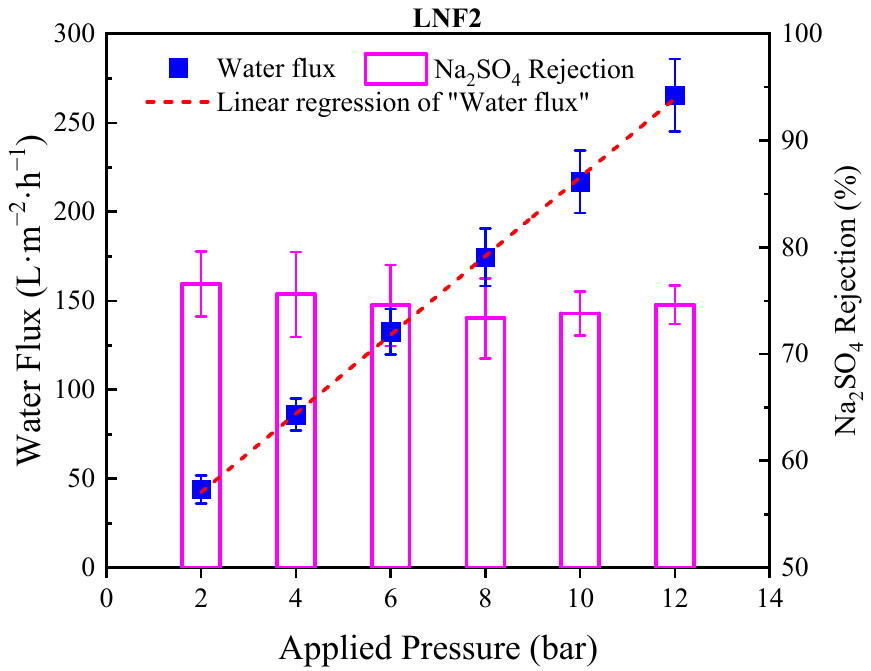
Figure 4. Water flux and Na 2 SO 4 rejection for LNF2 membrane tested at different pressures. The straight red dashed line is linear regression of water flux-applied pressure relationship with the slope (k) equal to 22.5 L/m 2 /h/bar, which was identical to the A value of membrane.